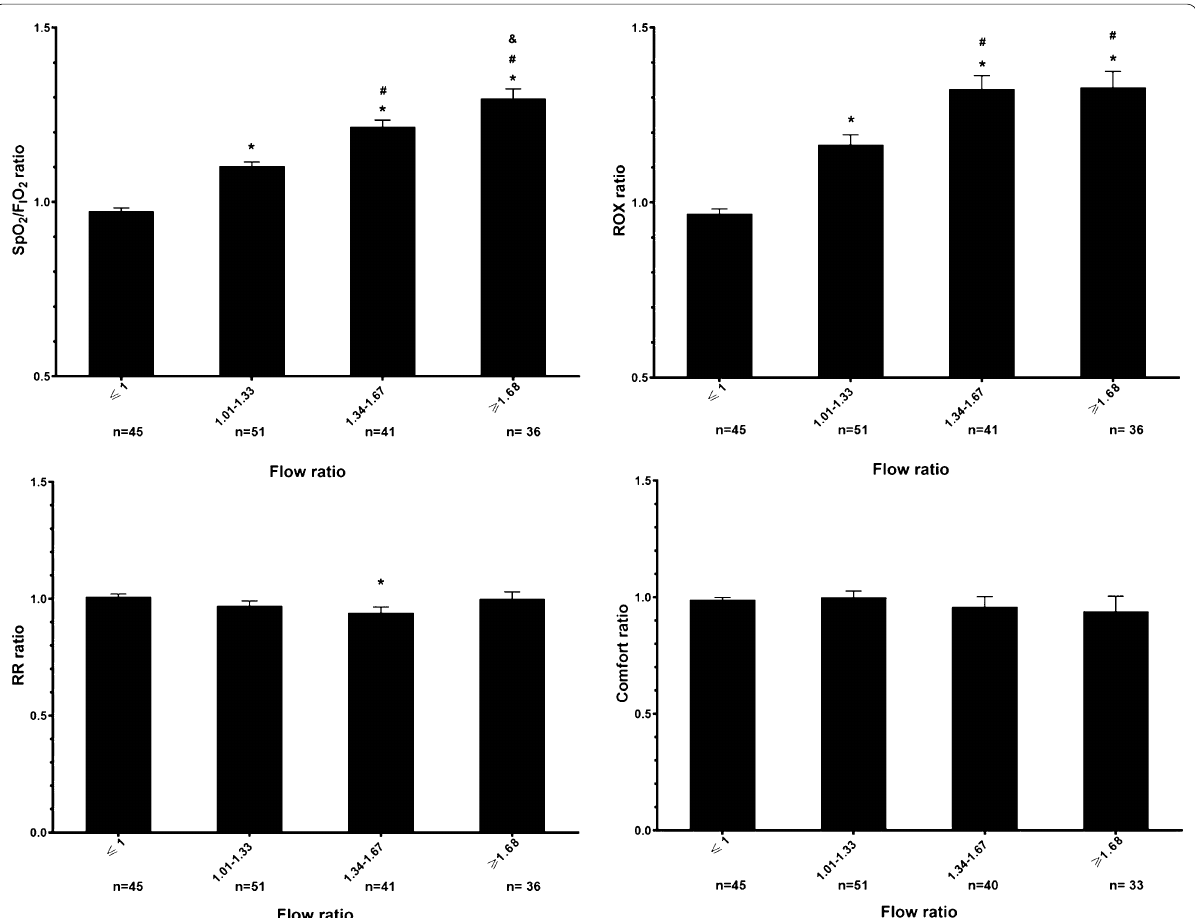
Fig. 2 Patient response to different flow ratios. On the top 2 figures, X-axis is the flow ratio of setting HFNC flow to patients’ peak inspiratory flow during tidal breathing and the flow ratios are divided into four groups ( SpO 2 /F I O 2 (left top) or ROX (right top) at the flow setting to SpO 2 /F I O 2 or ROX at their matching flow are shown. As the flow ratio increased, the SpO 2 /F I O 2 ratio increased. Similarly, compared to ROX ratio with flow ratios ROX ratio did not increase beyond flow ratios of 1.34–1.67. RR ratio was lower with flow ratios of 1.34–1.67 than with flow ratios No significant differences of comfort score ratios were found at different flow ratios (right bottom). * p < 0.05 compared to flow ratios compared to flow ratios of 1.01–1.33. & p < 0.05 compared to flow ratios of 1.34–1.67. SpO 2 , pulse oximetry; F I O 2 , fraction of inspired oxygen; RR, respiratory rate; ROX (SpO 2 /F I O 2 =